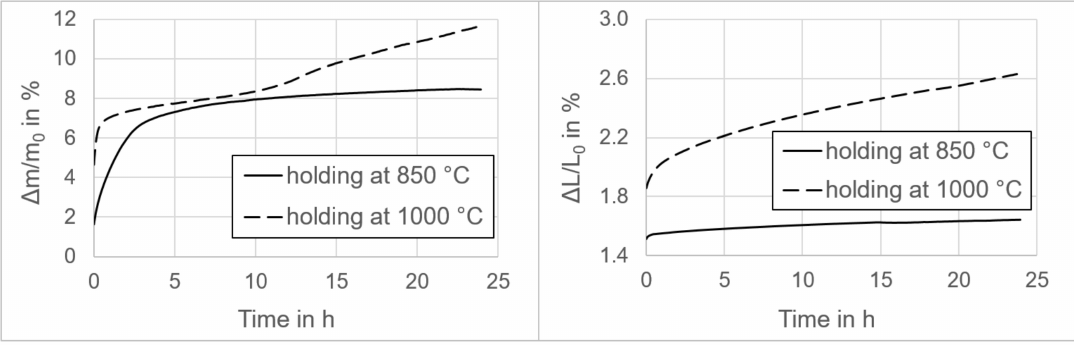
Figure 5. Isothermal thermogravimetry ( left ) and dilatometry ( right ) analyses of 316L–40MgO under air atmosphere as a function of time up to 24